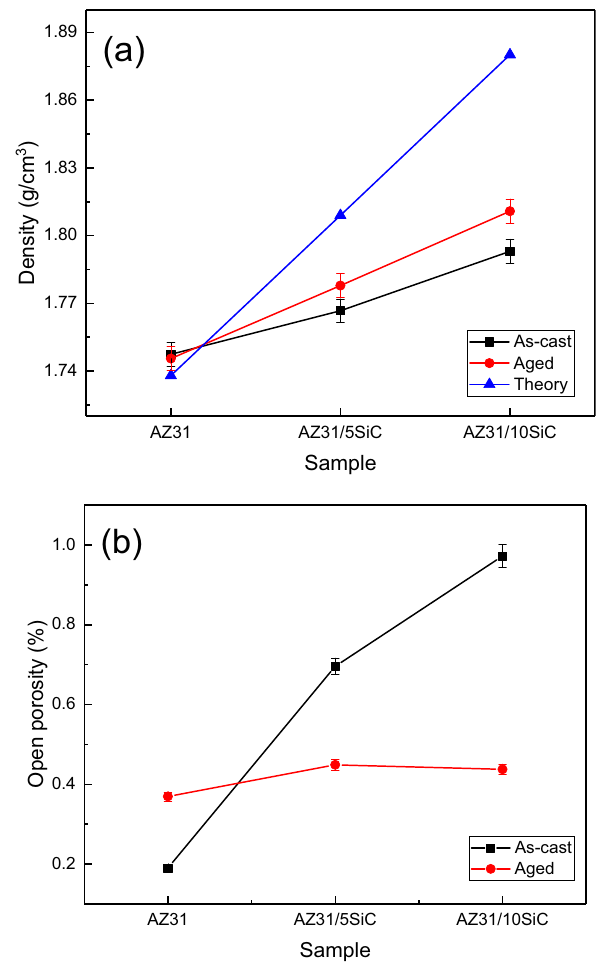
Figure 7. ( a ) Density of as-cast and aged samples, and ( b ) open porosity of as-cast and aged